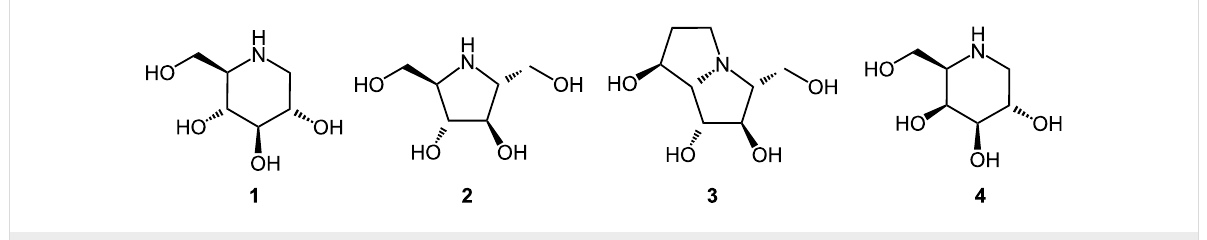
Figure 1: Typical representatives of iminosugars.